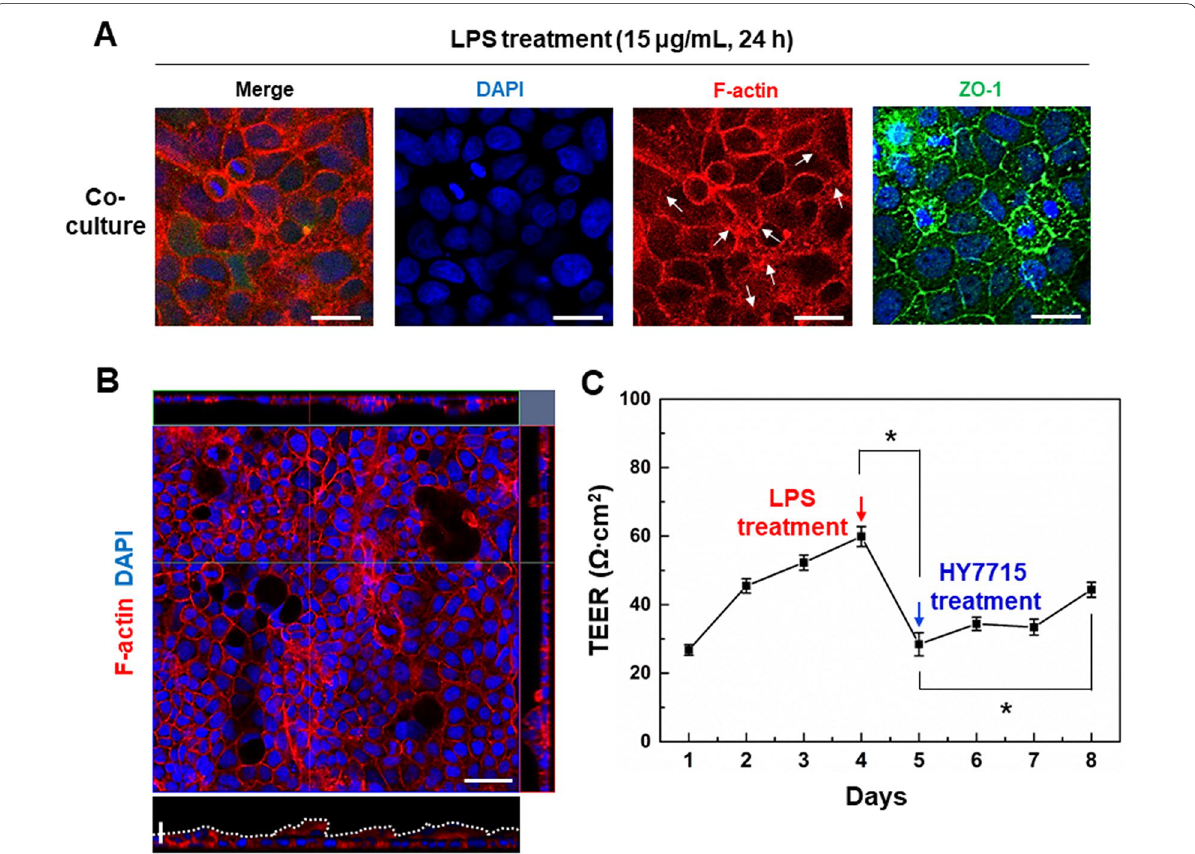
Fig. 7 Induction of pathological intestinal injury induced by non‑pathogenic LPS endotoxin and anti‑inflammatory effect evaluation of probiotics. A Morphological analysis of the intestinal barrier damage in response to LPS addition. Scale bars are 25 μm. B Fluorescence confocal micrographs (vertical cross‑sectional views) of villi recorded at 5 days after staining with F‑actin. Horizontal scale bar is 50 μm and Vertical scale bar is 25 μm. C Quantification of the intestinal barrier function evaluated by calculated TEER analysis (* p <